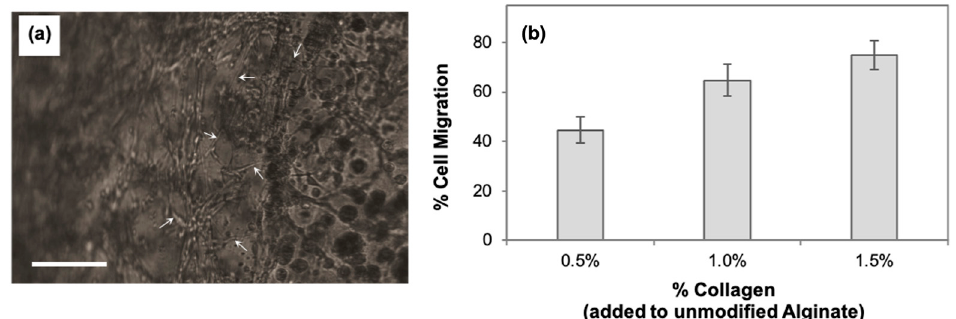
Figure 3. ( a ) Representative phase-contrast image showing migrated U87 cells into 0.5% unmodified alginate scaffolds containing 1% collagen on day 3. The scale bar depicts 100 µm. The image shows that cells extended processes in alginate containing collagen (as indicated by the white arrows). ( b ) Migration of U87 cells into 0.5% unmodified alginate scaffolds containing collagen in different amounts after three days. Error bars represent the standard deviation of three biological samples.